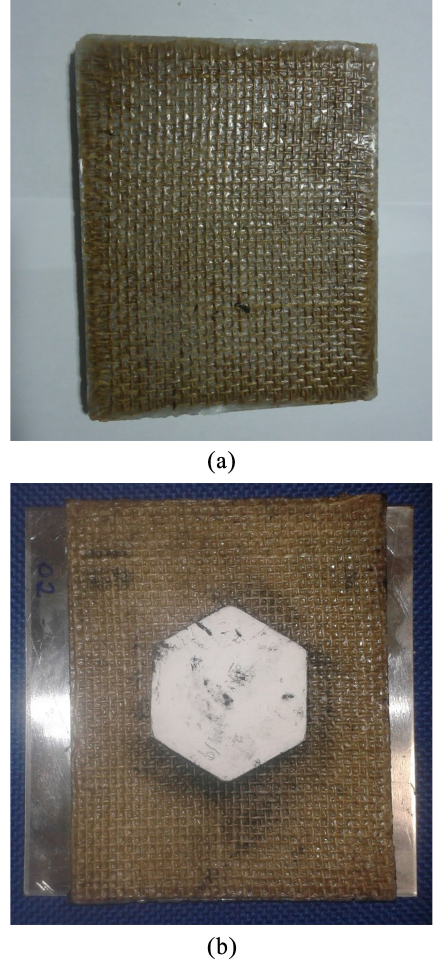
Figure 2. Plate of jute fabric composite (a) and the actual front view of a typical complete MAS investigated